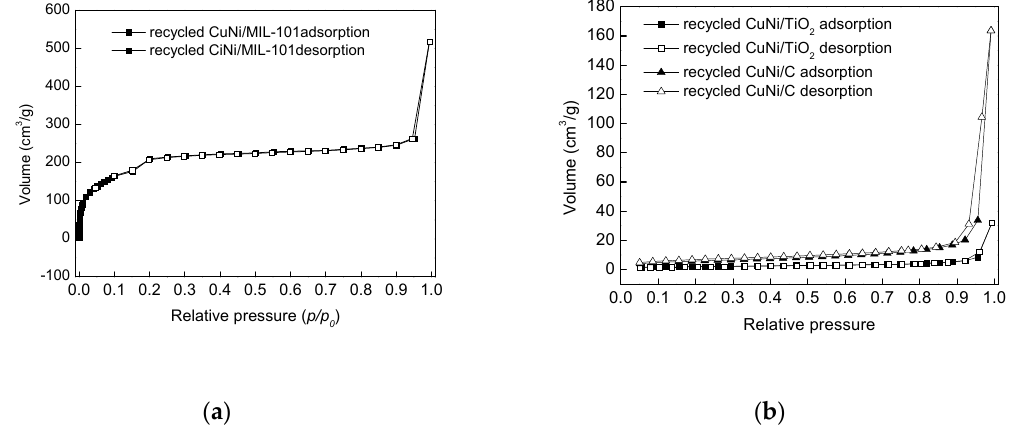
Figure 10. Nitrogen adsorption–desorption isotherms of the samples measured at 77 K: (a) recycled CuNi/MIL-101; (b) CuNi/TiO 2 and CuNi/C.